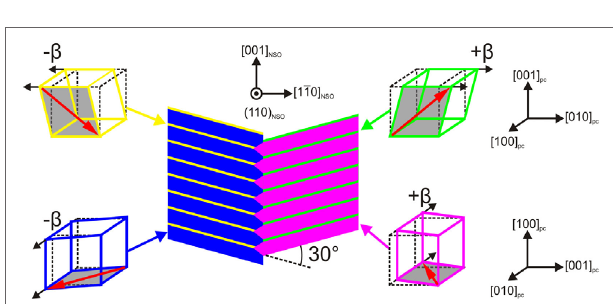
FigUre 10 | Model of the herringbone pattern in K 0.9 Na 0.1 NbO 3 thin films on NdScO 3 substrates exhibiting an interlaced a 1 a 2 and M C domain structure.